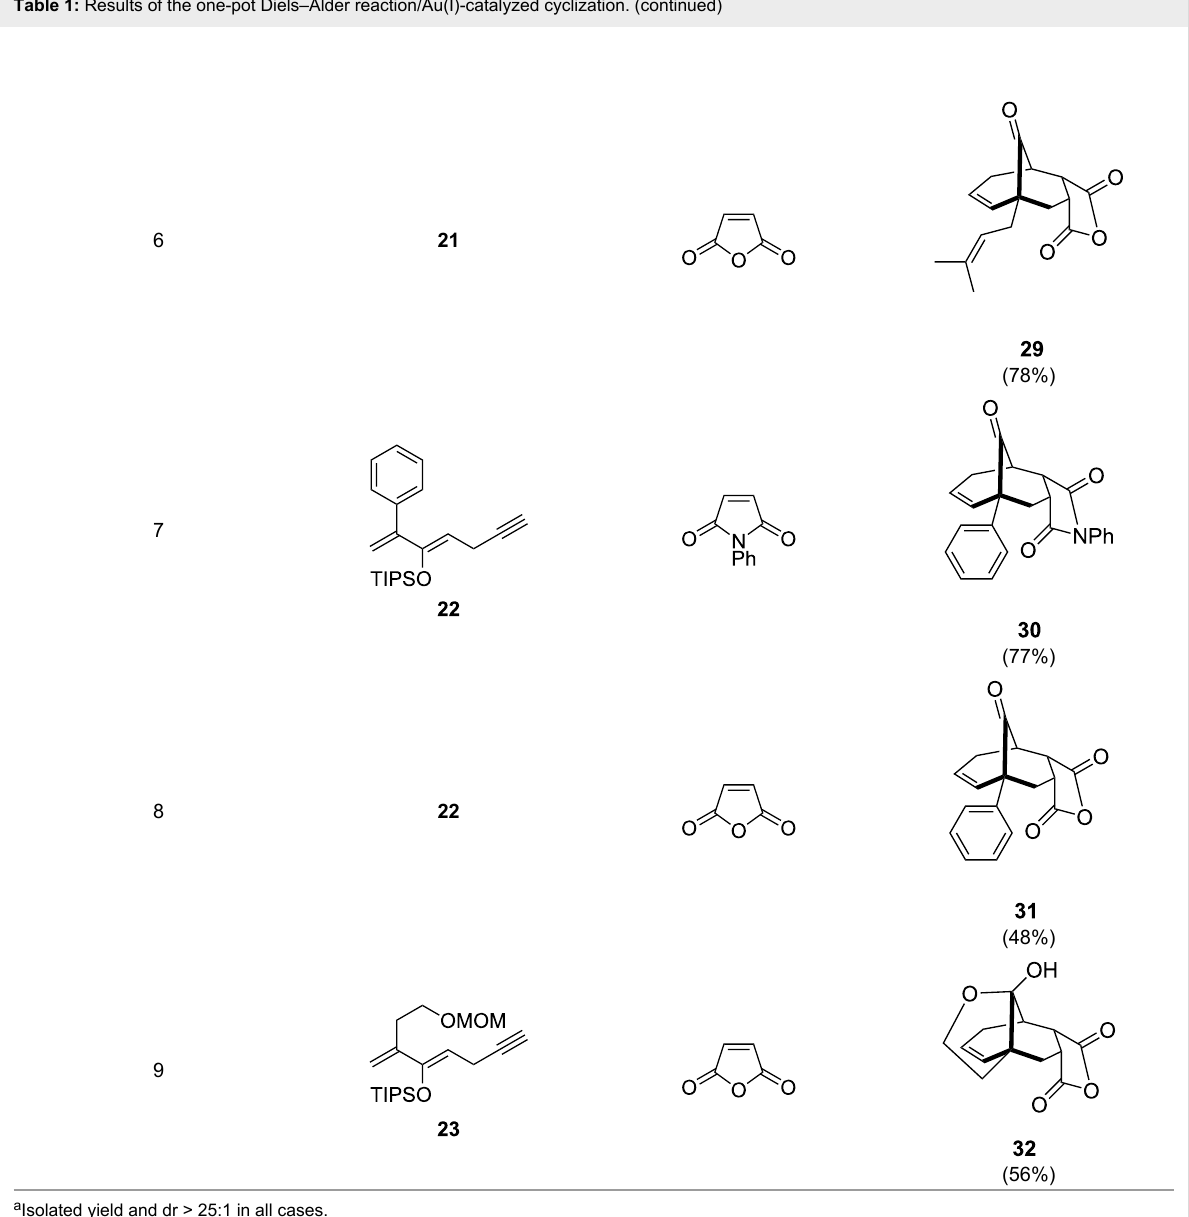
Table 1: Results of the one-pot Diels–Alder reaction/Au(I)-catalyzed cyclization.